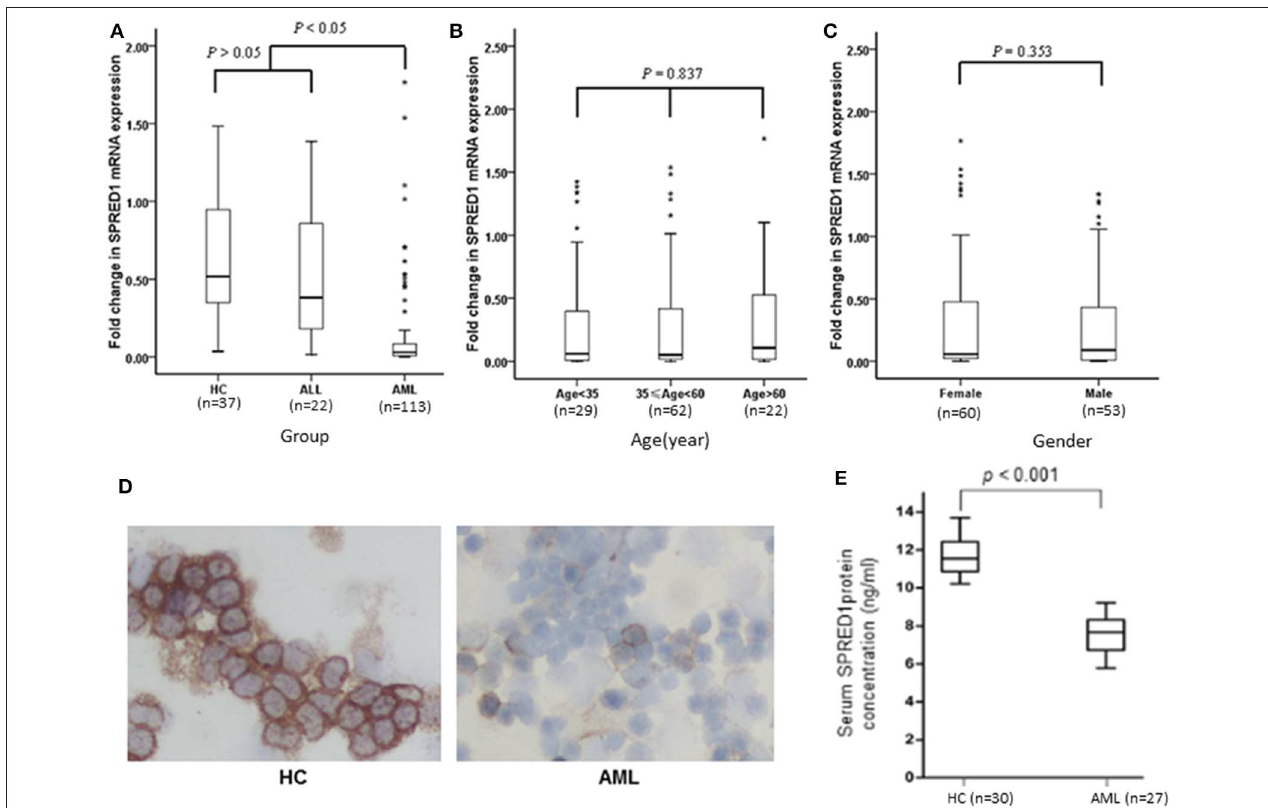
FIGURE 1 | Box plots of SPRED1 mRNA expression in all subjects. SPRED1 mRNA expression (A) in healthy controls (HC), ALL and AML groups (Kruskal–Wallis test); (B) by different age groups (Kruskal–Wallis test); (C) between female and male (Wilcoxon tests); (D) representative immunocytochemical staining of SPRED1 protein in BM cells. Positive expression of SPRED1 was stained brown in BM of HC while negative expression of SPRED1 in BM of AML patient. (E) Serum SPRED1 level in AML patients (7.52 ± 0.93ng/ml) and HC (11.68 ± 0.94ng/ml) (Wilcoxon